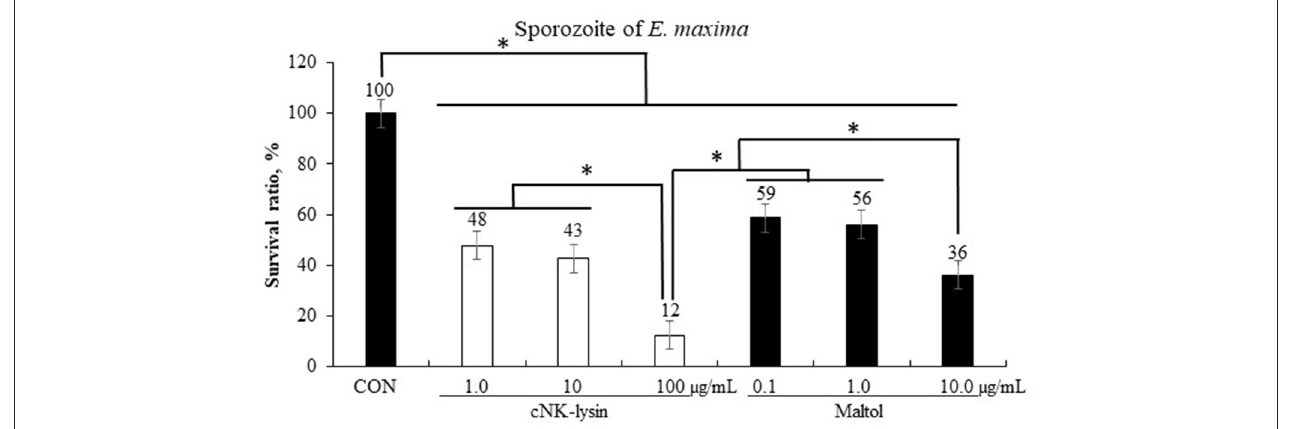
FIGURE 5 | Anticoccidial effect of maltol on sporozoites of E. maxima in experiment 1. Each bar represents the mean ± SEM ( n = 3). Significant results are marked as * ( P < 0.05). CON, 2.5 × 10 5 sporozoites/mL.